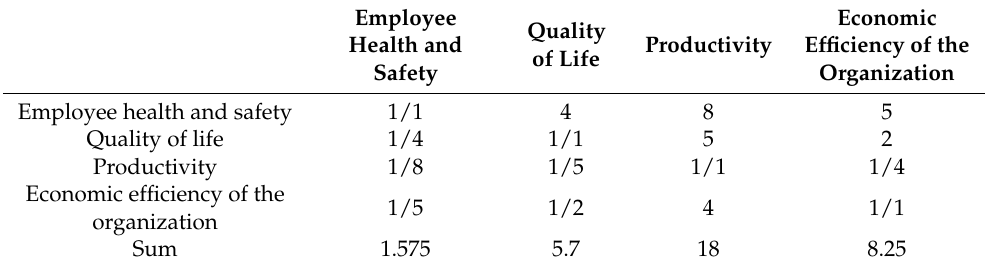
Table 2. Comparison matrix.